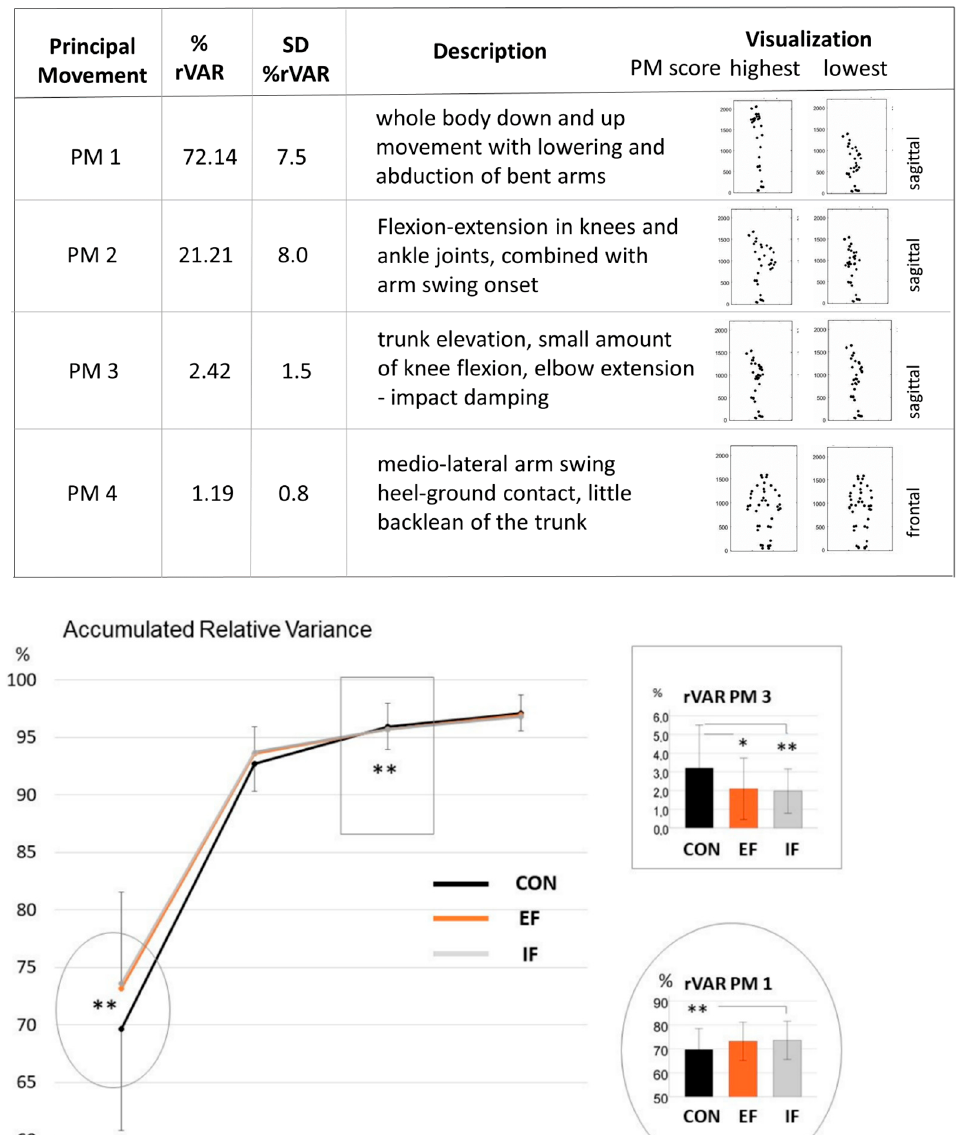
Table 1. Principal movements (PMs) explaining more than 1% of the variation, mean explained variance with a short description, and visualization by athletes’ positions for the highest and lowest score of the selected PM.